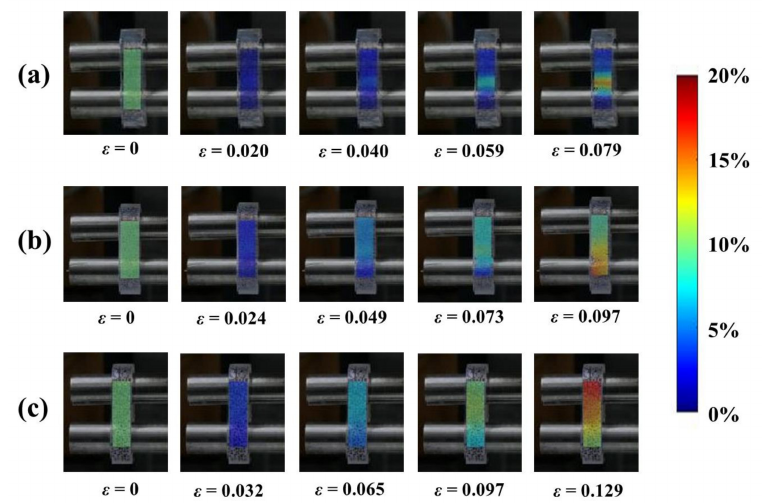
Figure 4. Digital image correlation (DIC) analysis of the local strain of agarose-xanthan gel systems during a ring tensile elongation until failure: ( a ) A:X = 1:0; ( b ) A:X = 0.75:0.25; ( c ) A:X = 0.5:0.5. A is agarose and X is